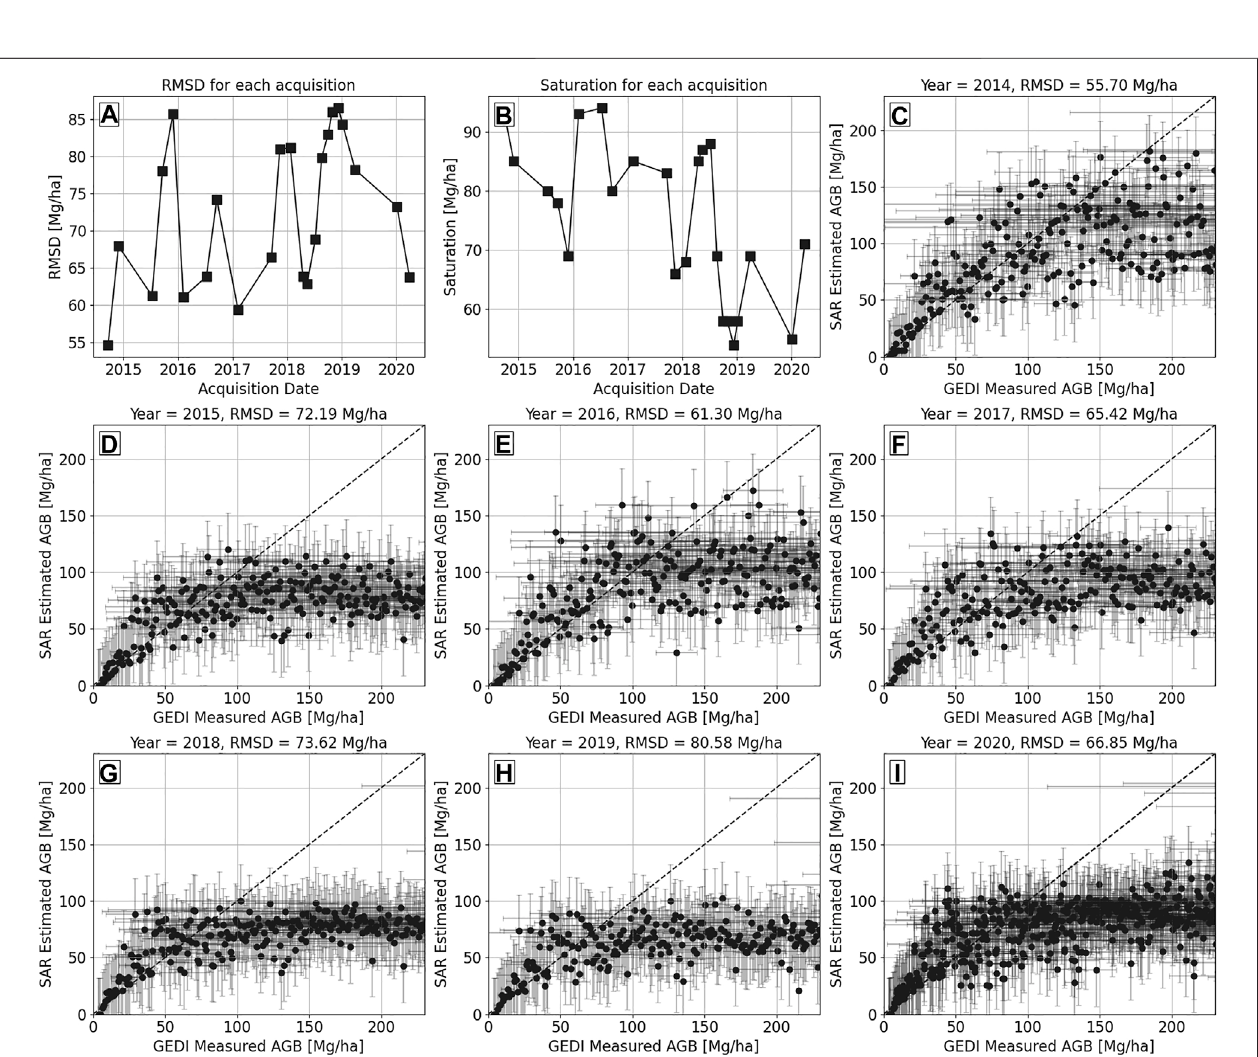
Frontiers in Earth Science |